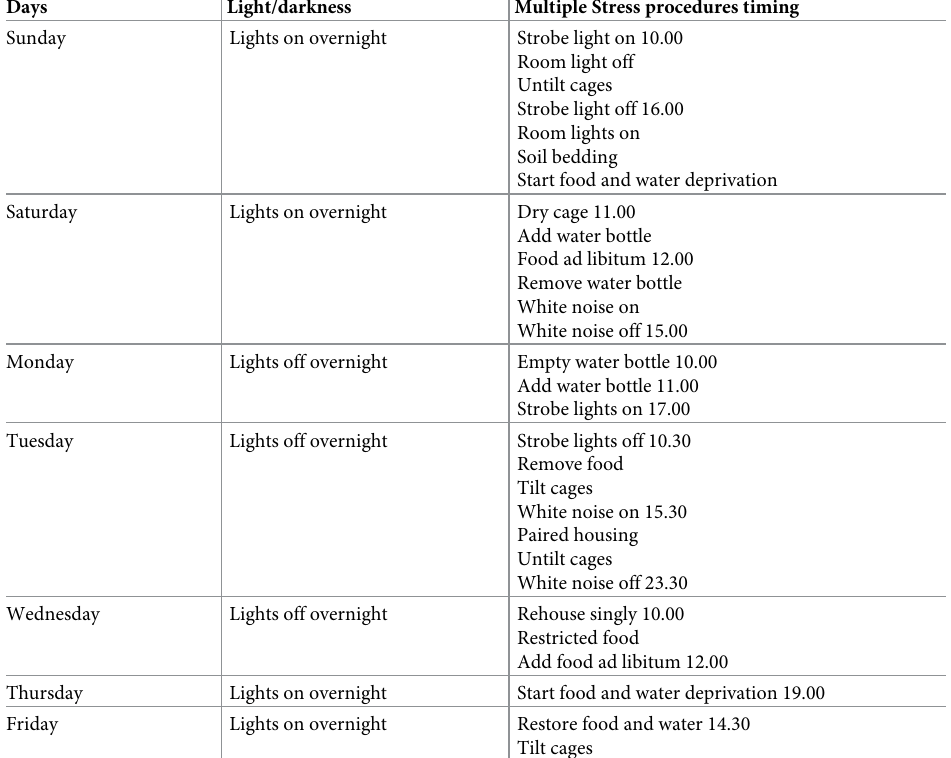
Table 1. Schedule of chronic